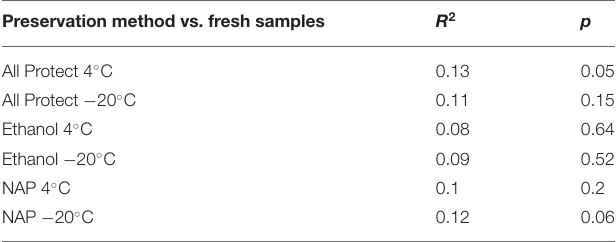
TABLE 3 | Pairwise comparisons of beta-diversity between all preservation treatments and the control. Preservation method vs. fresh